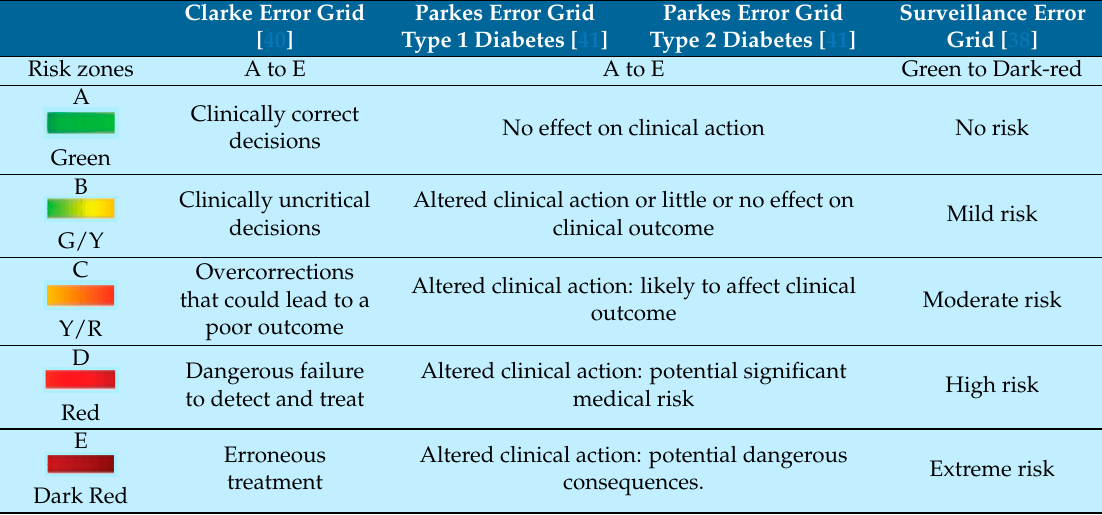
T able 3. Standard error grids for clinical accuracy assessment of glucose detection.